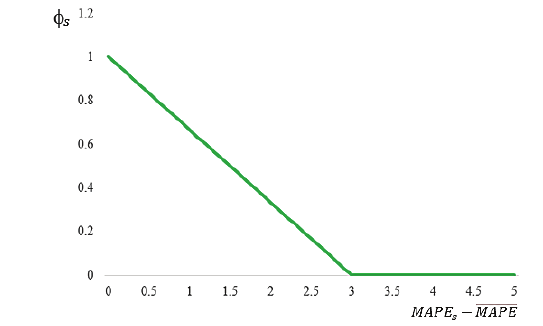
Figure 2. An example of the relationship between the performance gap and model weighting (θ = 3)